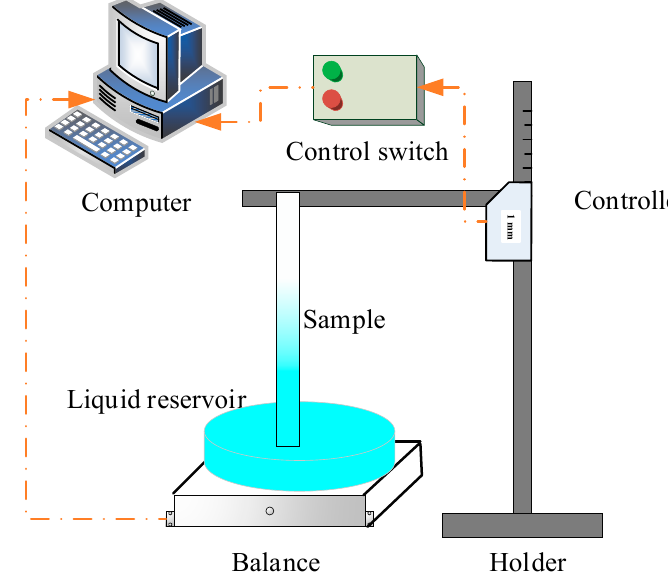
Figure 1. Schematic of the capillary rate ‐ of ‐ rise test apparatus.